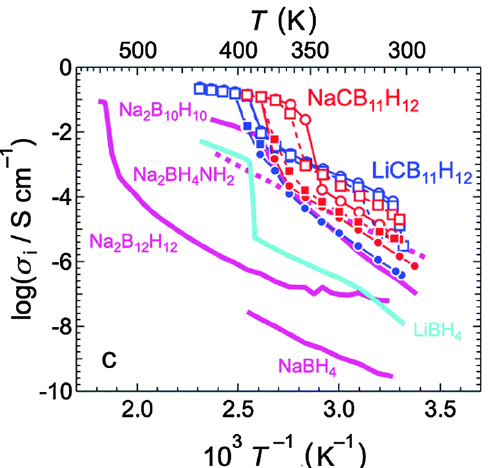
Figure 17. Ionic conductivities measured by Tang et al. for LiCB 11 H 12 (blue) and NaCB 11 H 12 (red), plotted with comparisons of other related materials. Conductivities are plotted as a function of inverse temperature. Circles and squares denote the conductivities of the respective 1st and 2nd temperature cycles. Closed and open symbols denote respective heating and cooling processes. Reprinted from